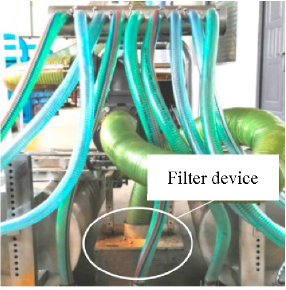
Figure 9. Filter device.